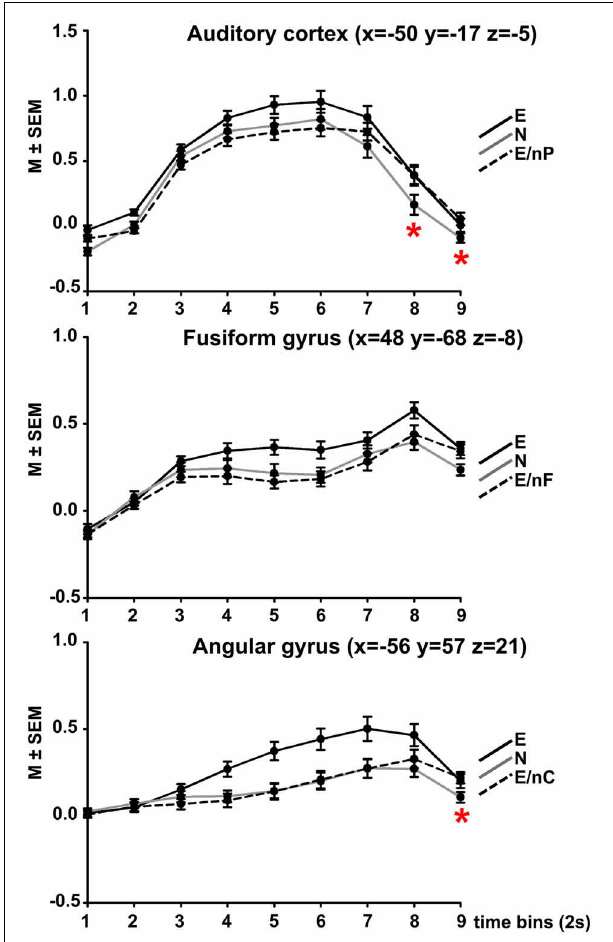
FIGURE 2 | Results of Finite Impulse Response (FIR) analyses in three modality-responsive regions (AC, FFG, AG, peak coordinate in brackets). Within each sphere (10mm around peak amplitude, whole AC, respectively), the time-course of activation within three selected experimental conditions is displayed across 9 time-bins of 2s each. Black coloring indicates the time-course of the all emotional (E) condition, gray coloring indicates condition all neutral (N), dotted black coloring indicates the bimodally emotional condition in which the input of the modality-responsive region was neutral (E/nP in the AC, E/nF in the FFG, E/nC in the AG). Red asterisks indicate at which time point the respective bimodally emotional condition significantly surpassed the fully neutral condition (N). For all post-hoc pairwise comparisons between all three conditions at each time-point please refer to Table S1 in the